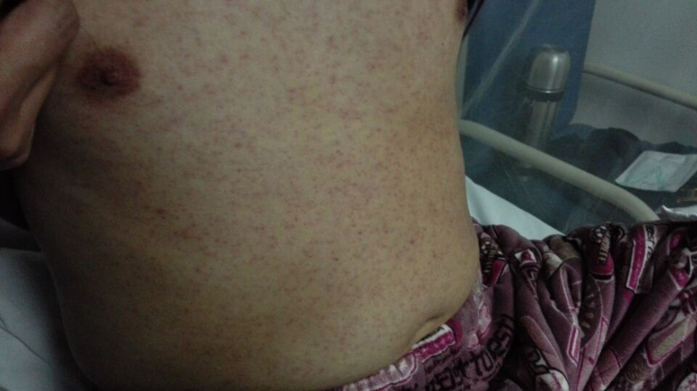
Rashes on the body of the index cases on February 17th, 2016.